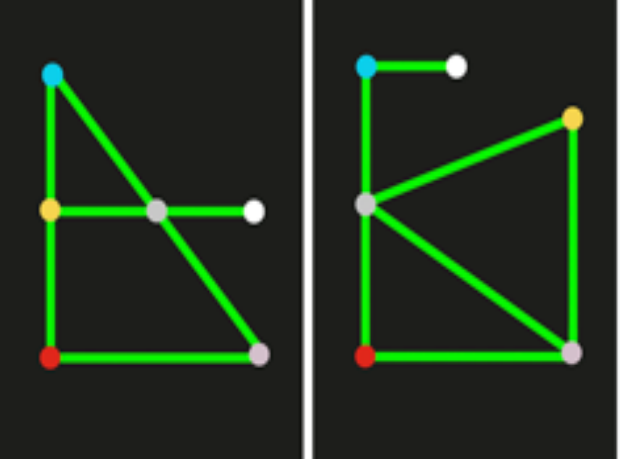
Figure 2. Experimental maps rendered on the Samsung galaxy Tab-3 Android tablet.